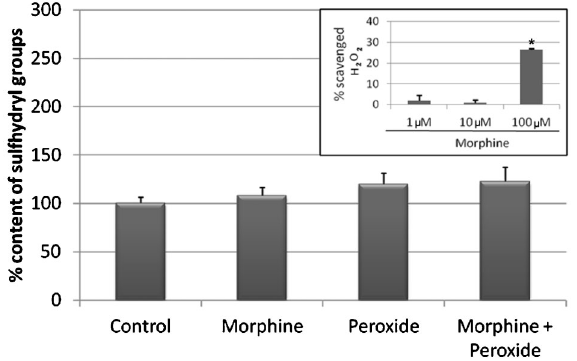
Figure 3. Content of sulfhydryl groups in the C6 cell line exposed to 0.0025% hydrogen peroxide (H 2 O 2 ) and/or 1 m M morphine for 24 h. The insert shows levels of scavenged H 2 O 2 in vitro in the presence of 1-100 m M morphine. Data are reported as means±SE. *P , 0.05 vs all groups (ANOVA and Tukey